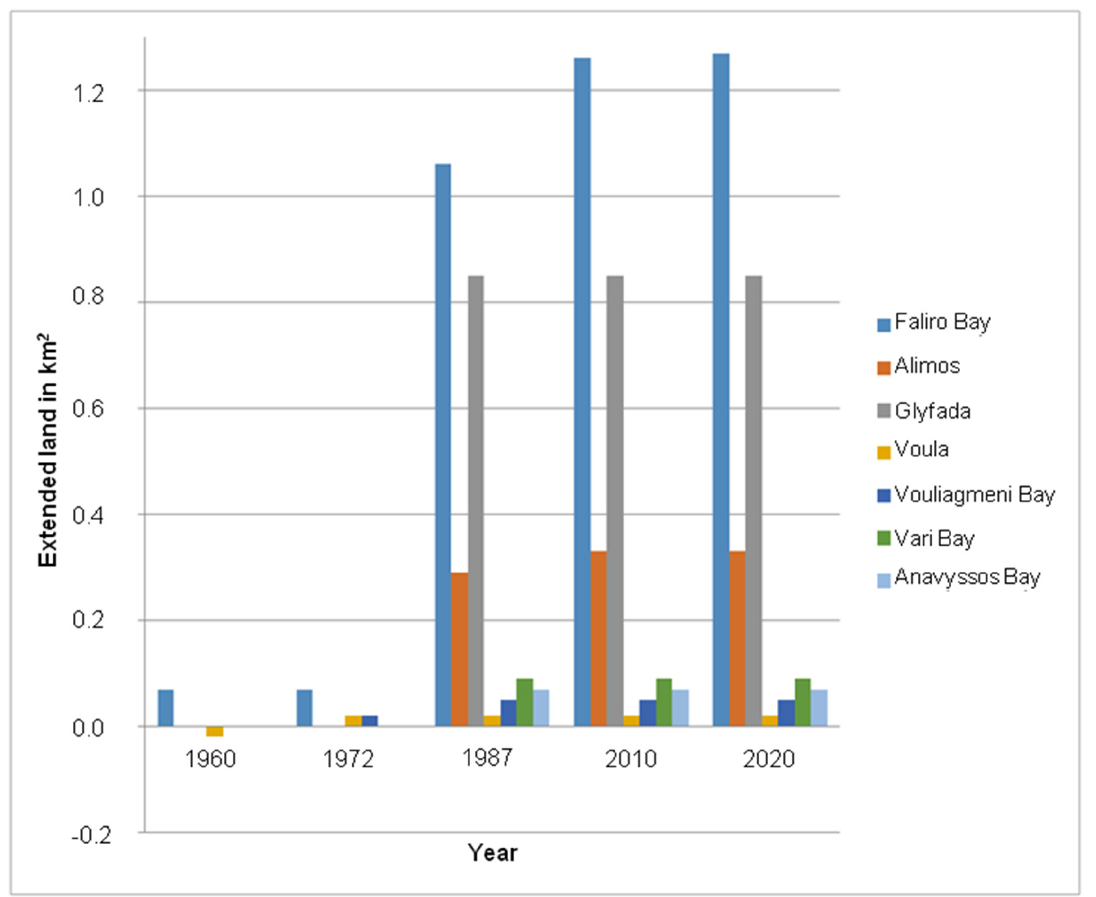
Figure 12. Graphical presentation of land increase in each examined year for the seven subareas. Moreover in the other two subareas, Alimos and Glyfada the artificial surfaces took up the coastal area. In Alimos, the length of the coastline increased by 256%, while the artificial interventions covered an area of 0.33 km 2 from 1945 to 2021 (Tables 2 and